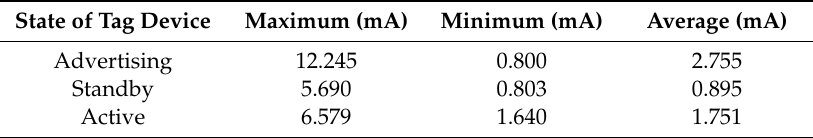
Figure 9. Power-consumption waveform of the tag device. Table 1. Power consumption of tag device according to its state.